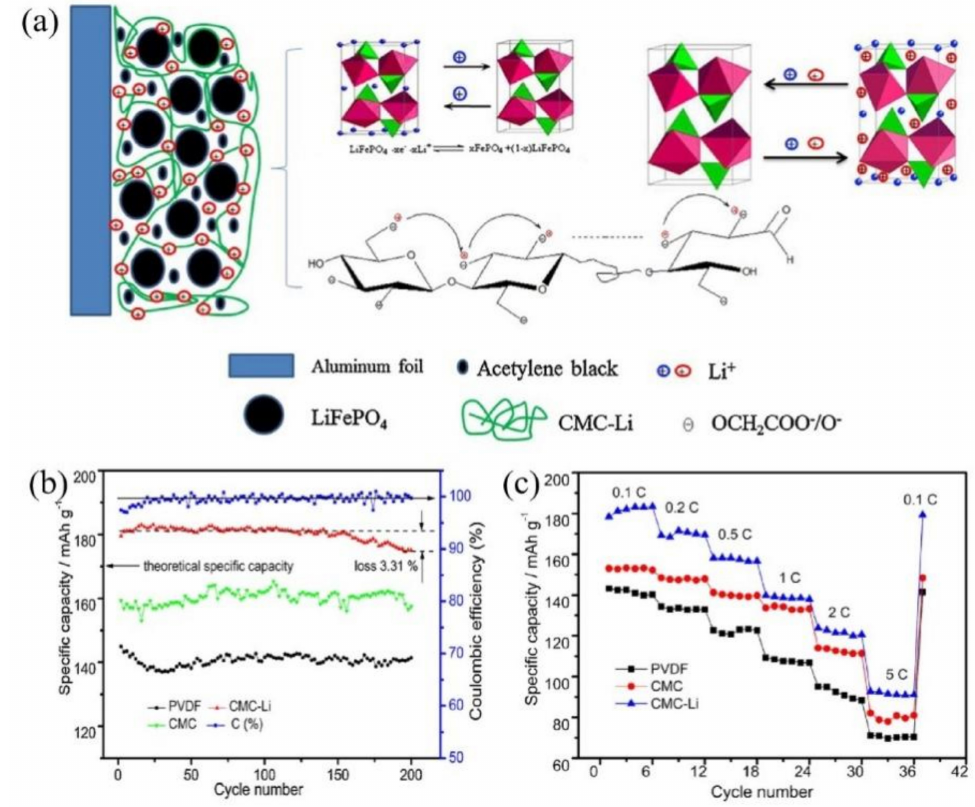
Figure 4. Preliminary investigation of the mechanism of the CMC-Li binder in LiFePO 4 battery and charge/discharge tests. ( a ) Preliminary investigation of the mechanism; ( b ) Specific capacity; ( c ) Rate performance. Reprinted with permission from ref. [67]. Copyright 2014